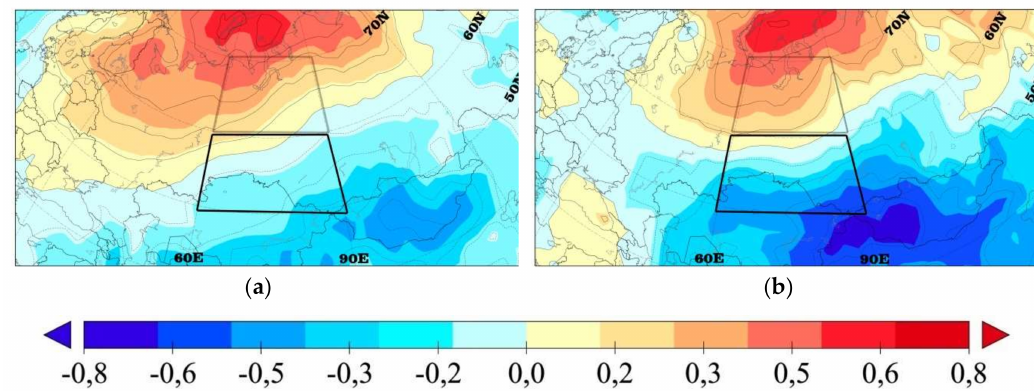
Figure 2. Correlation maps between the blocking frequency over Western Siberia (60 E–90 E) and the surface temperature for November–December ( a ) and January–February ( b ). The solid curve is the southern part of Western Siberia, the dashed curve is the northern part of Western